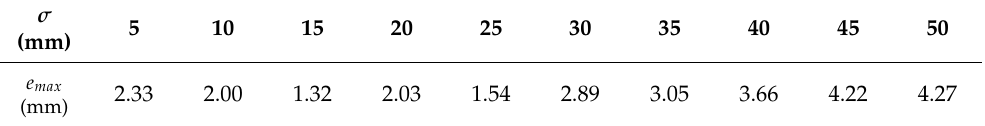
Figure 12. Visual representation of the lookup table for the Stanford Bunny at various measurement uncertainties: ( a ) 10 mm, ( b ) 30 mm, and ( c ) 50 mm. ( d ) Displays the minimal effect on the maximum vertex error reported by the PLuM algorithm in solving the registration problem depicted in Figure 7a using increasing lookup table uncertainties. Table 5. The maximum vertex error for varying values of the lookup table